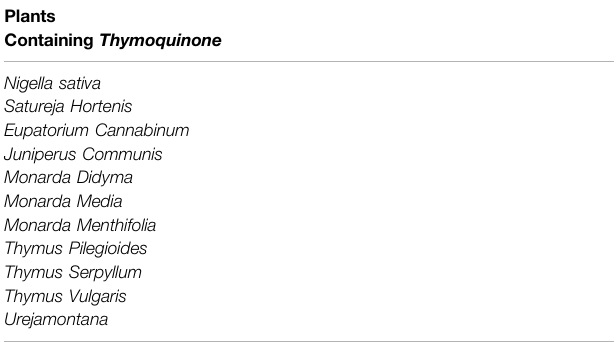
TABLE 1 | Plants containing Thymoquinone